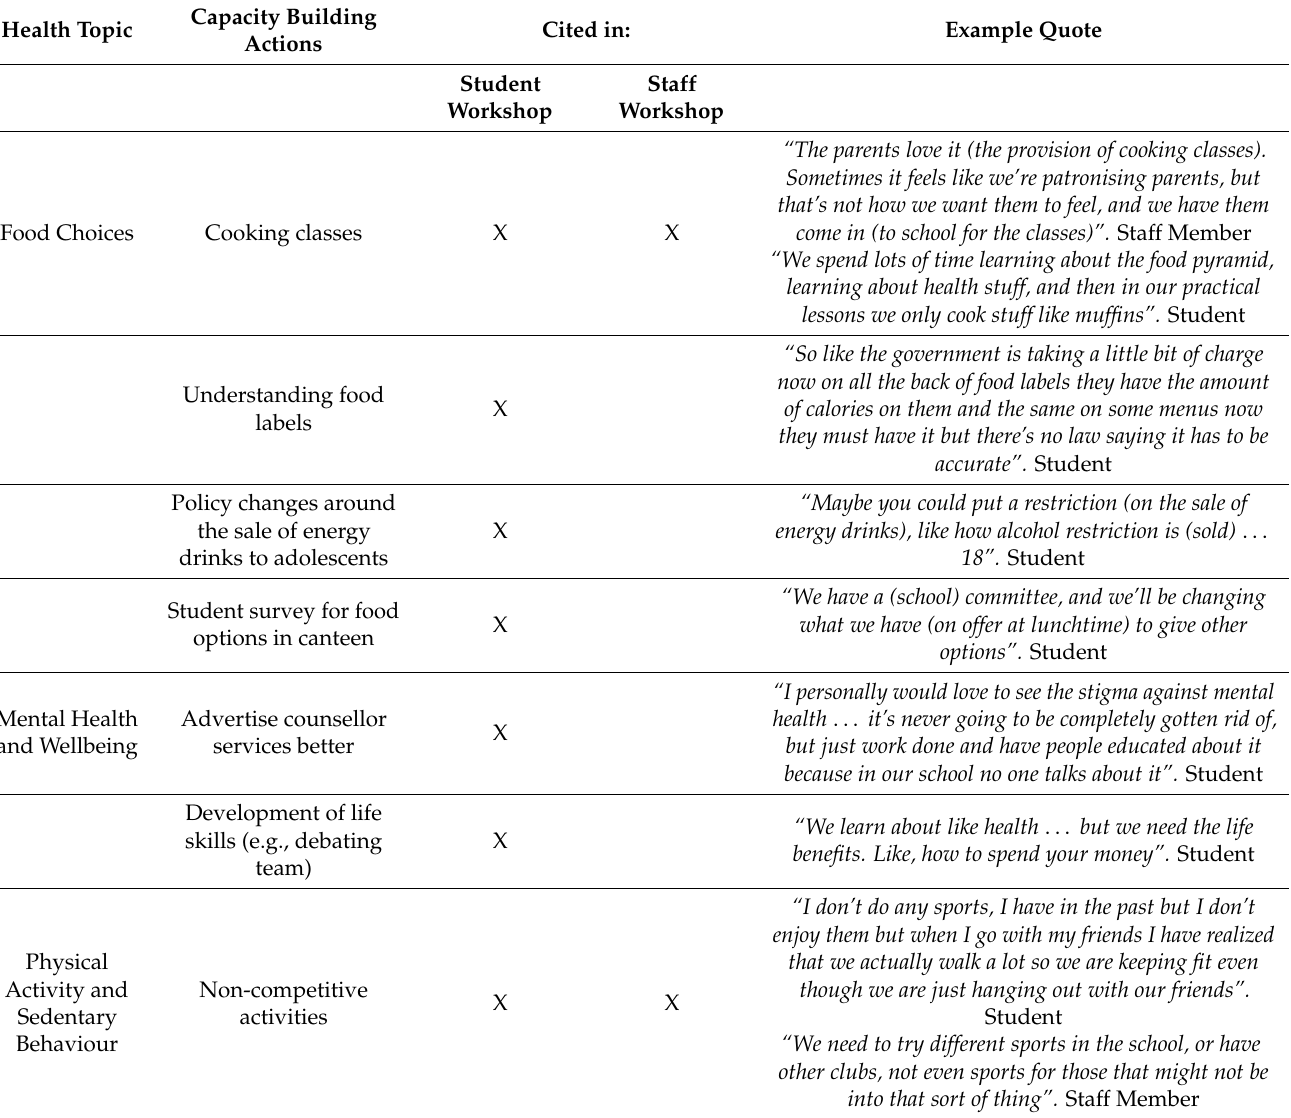
Table 2. Health topics and capacity building actions identified by